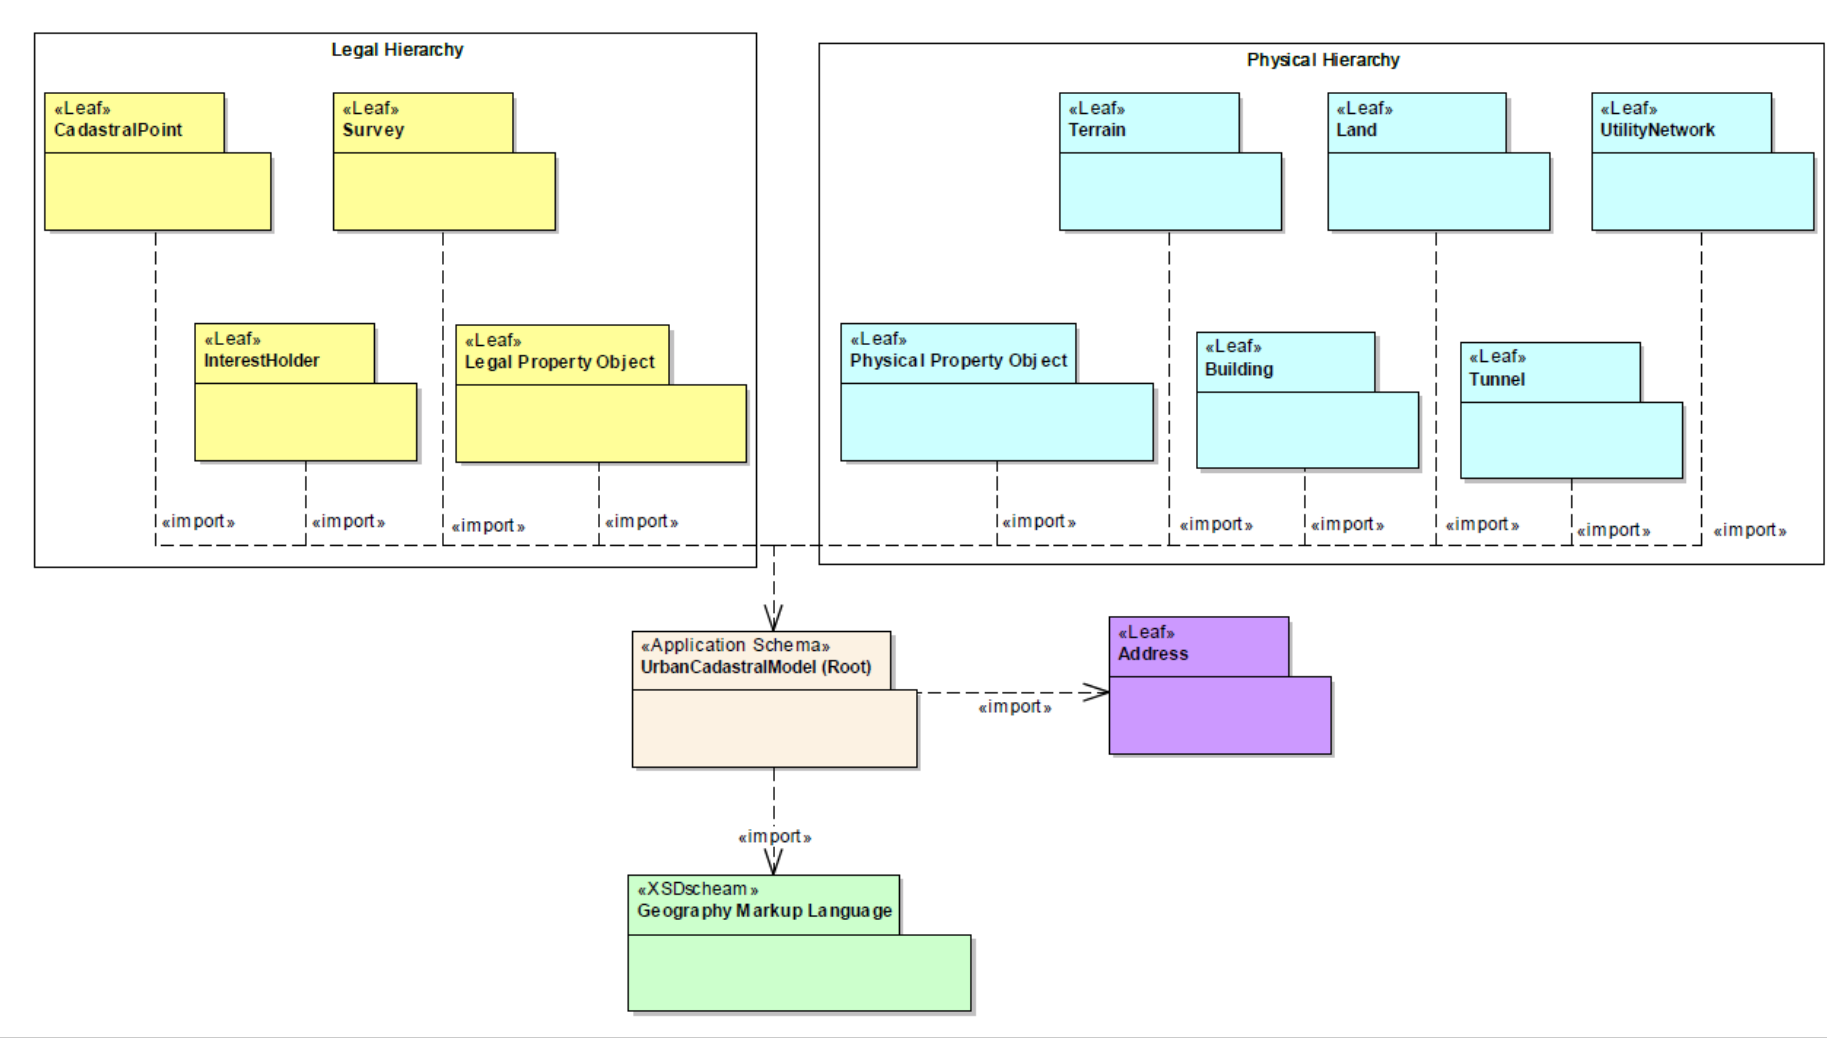
Figure 9. Separate models and hierarchies of the 3DCDM